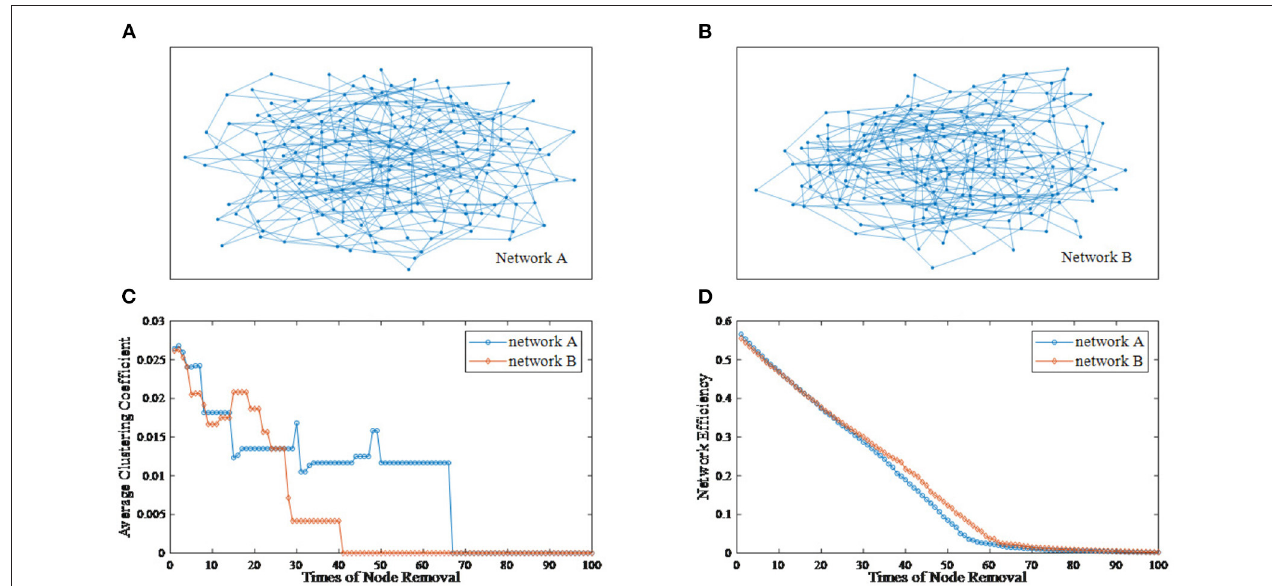
FIGURE 1 | An example of the node removal method. (A) Undirected network A. (B) Undirected network B. (C) The varying curves of the average clustering coefficient with the times of node removal. (D) The varying curves of the network efficiency with the times of node removal.